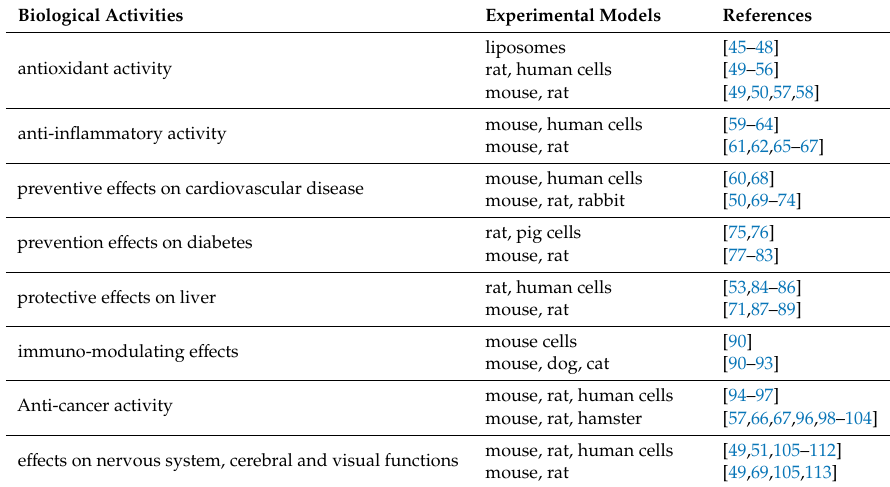
Table 1. Biological activities of astaxanthin revealed in in vitro and in vivo experiments.